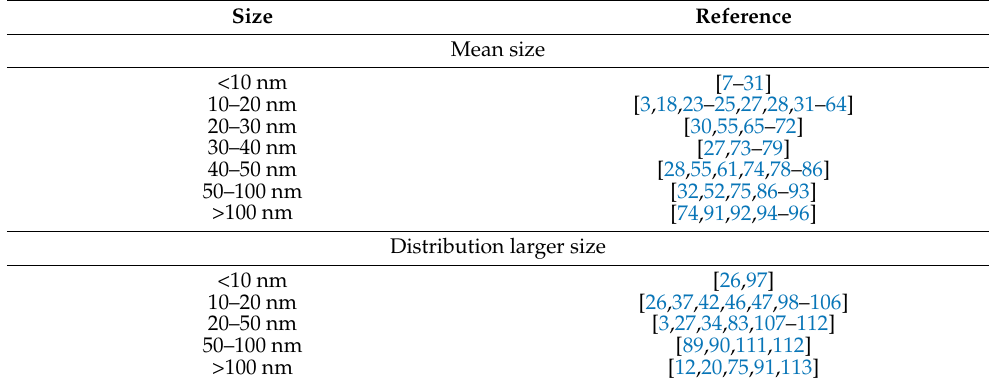
Table 1. Mean and maximum distribution size of nanoparticles that are used in dielectric nanofluids. Size